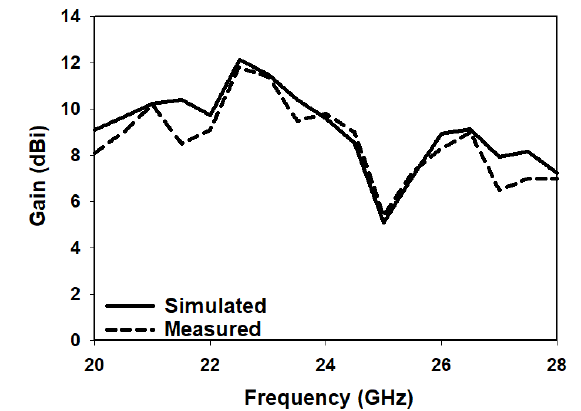
Figure 10. The gain for an array of two hemispherical DRAs with outlined positions on the ground